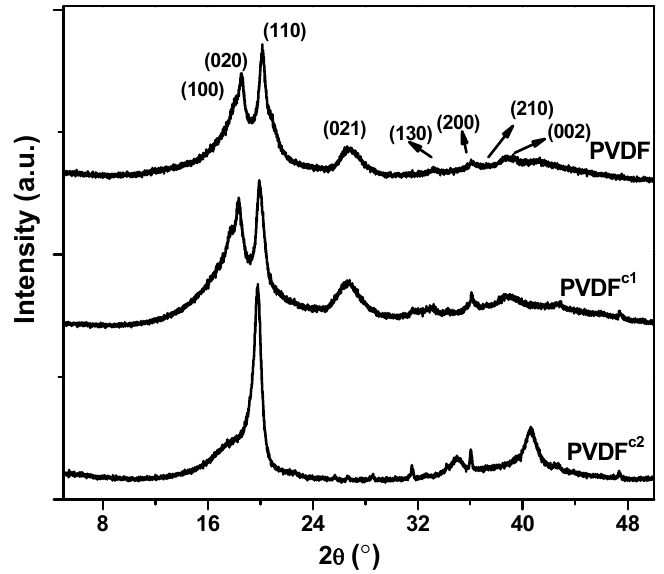
Figure 4. X-ray diffractograms of homer- and co-PVDF samples crystallizing from the